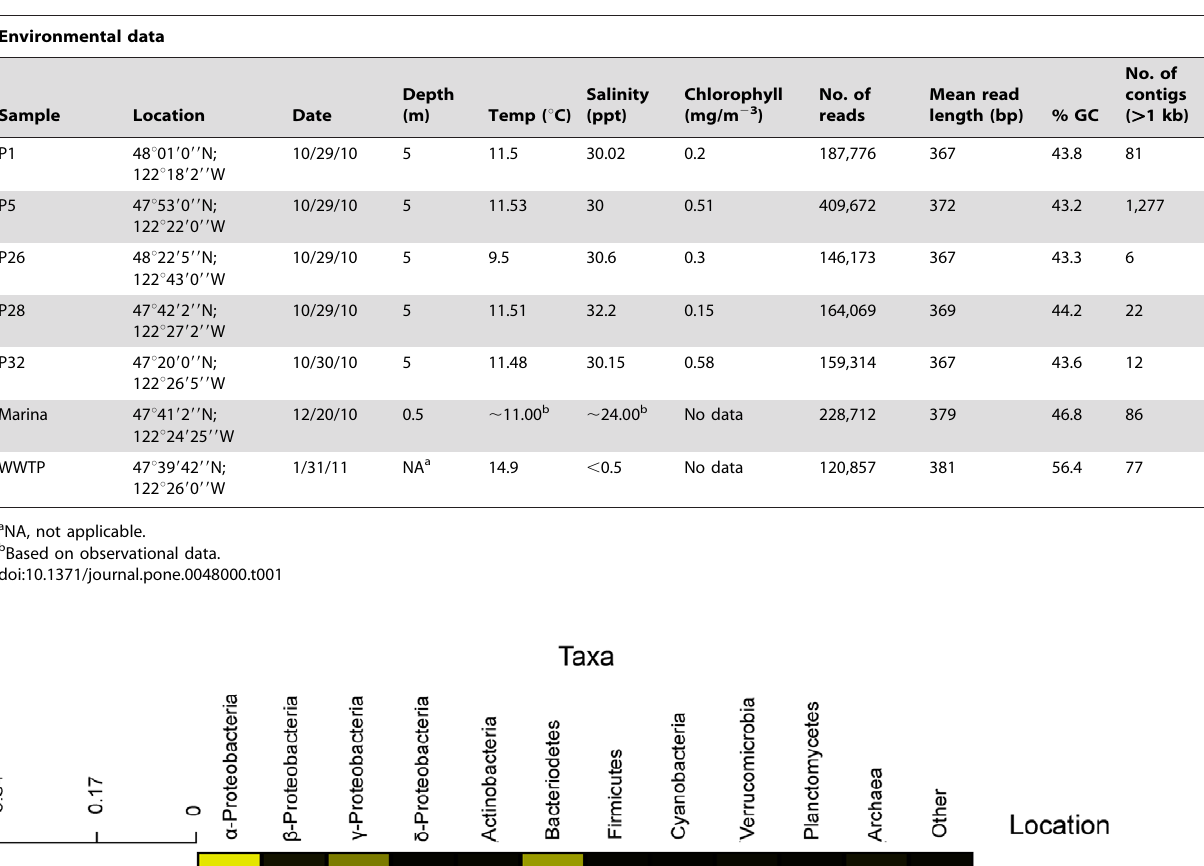
Environmental data